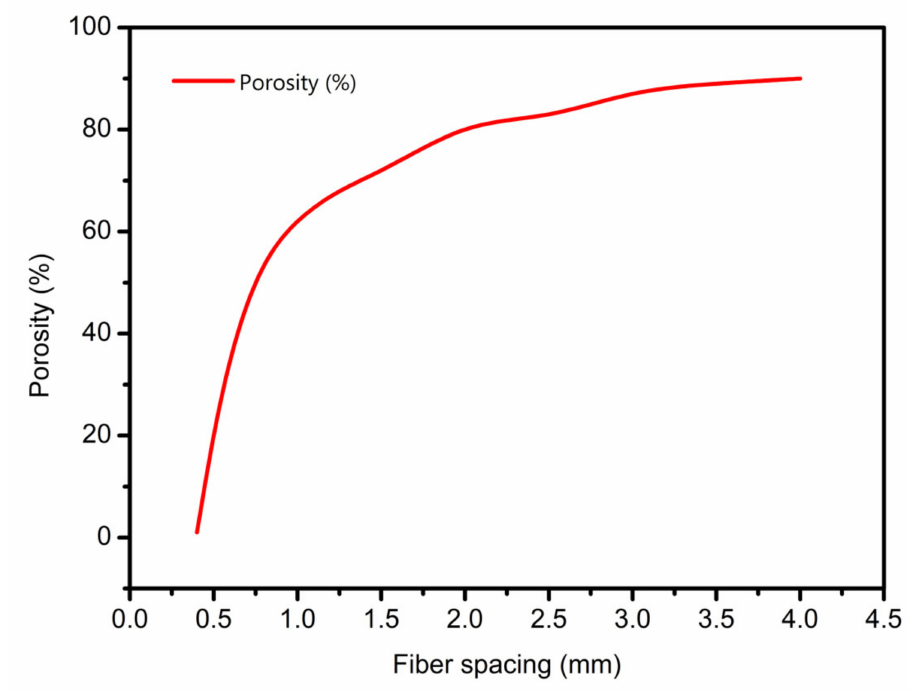
Figure 6. The prediction relationship curves of di ff erent fiber spacings with